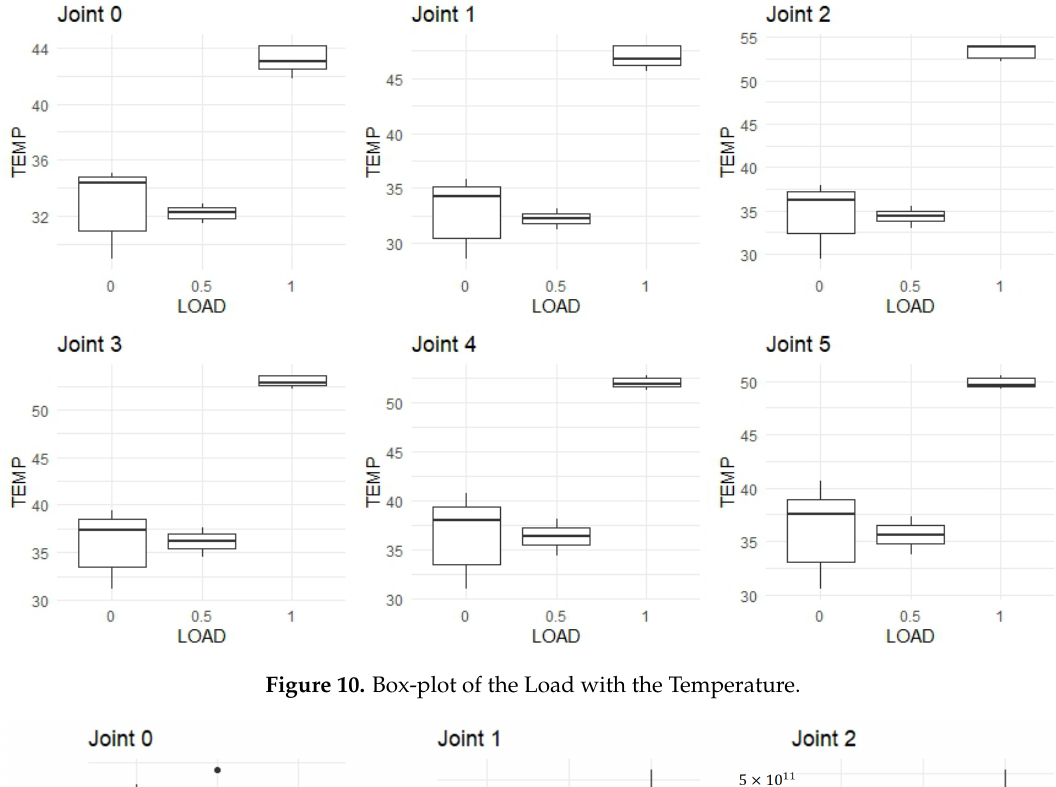
Figure 10. Box-plot of the Load with the Temperature.